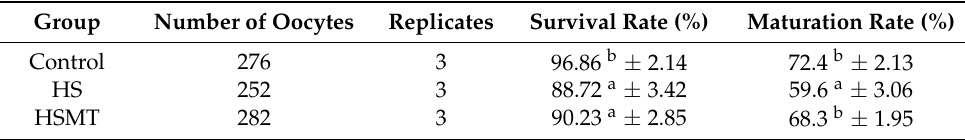
Table 2. Effects of heat stress and melatonin on oocyte survival rate and maturation